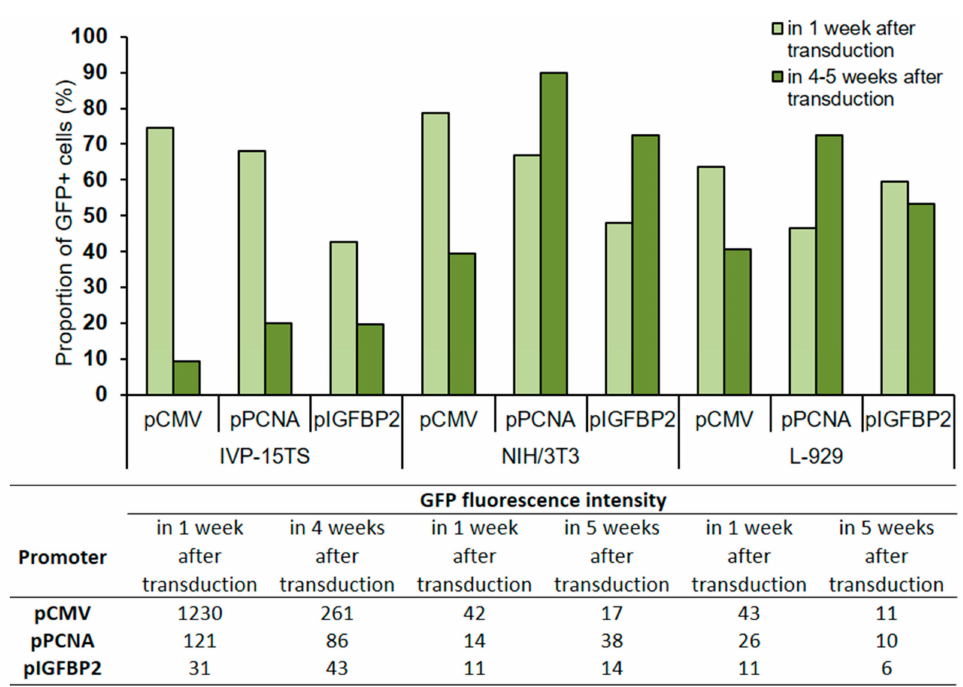
Figure 3. Proportion of GFP + cells and GFP fluorescence intensity in transduced cells after 1 and 4–5 weeks of culture post transduction. The total amount of cells in the analysis was taken for 100%. The analysis was performed 4 weeks after transduction for the primary culture (IVP15-TS) and 5 weeks after transduction for linear fibroblasts NIH / 3T3 and L-929. The names of promoters or cell lines are indicated below the abscissa axis and correspond both to the graph and to the